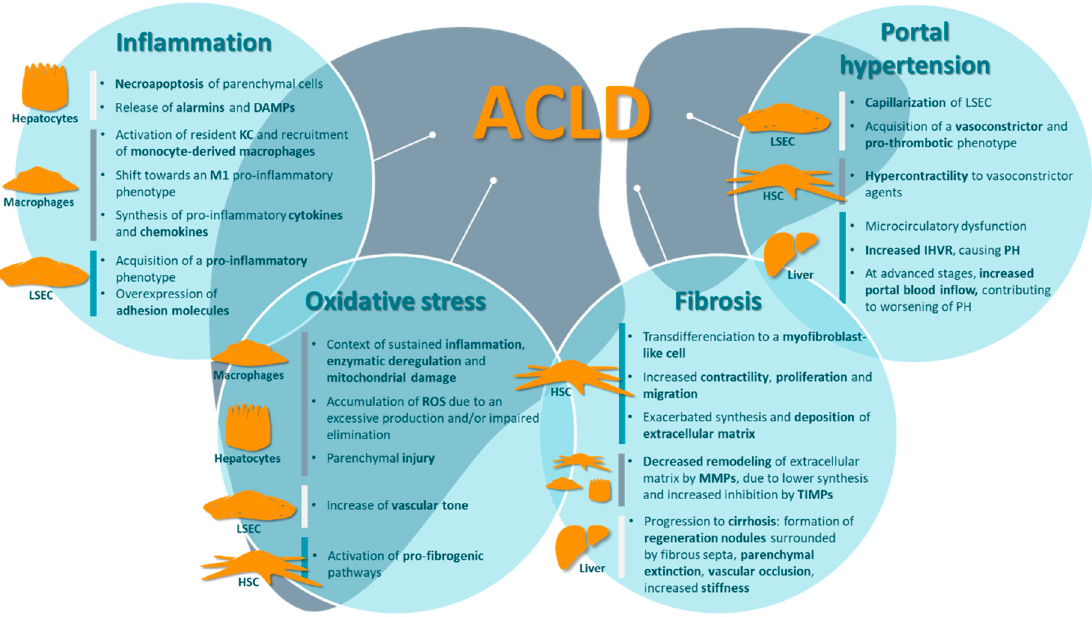
Figure 1. Major contributors of advanced chronic liver disease pathophysiology. ACLD involves a profound de-regulation of all hepatic cell types, including hepatocyte necroapoptosis, the shift of hepatic macrophages towards a pro-inflammatory phenotype, hepatic stellate cell activation, and liver sinusoidal endothelial cell capillarization. Altogether, these alterations contribute to a state of increased inflammation and oxidative stress, leading to the development of fibrosis and, ultimately, portal hypertension. ACLD, advanced chronic liver disease; DAMPs, damage-associated molecular patterns; HSC, hepatic stellate cells; IHVR, intrahepatic vascular resistance; KC, Kupffer cells; LSEC, liver sinusoidal endothelial cells; MMPs, metalloproteinases; PH, portal hypertension; ROS, reactive oxygen species; TIMPs, tissue inhibitors of metalloproteinases.